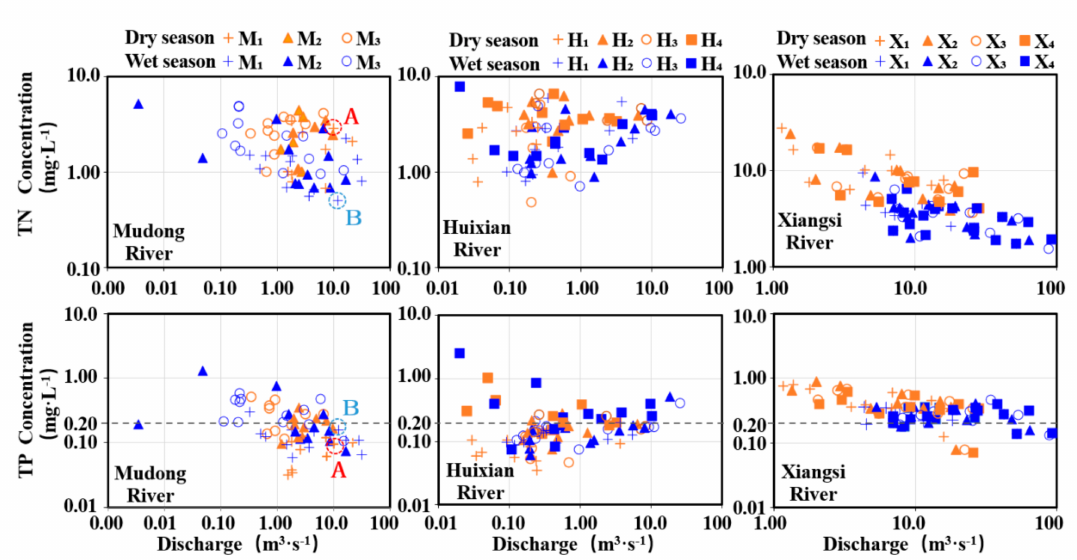
Figure 4. Total nitrogen (TN) and total phosphorus (TP) concentration–discharge relationships at the eleven monitoring sites of three rivers in the dry and wet seasons.